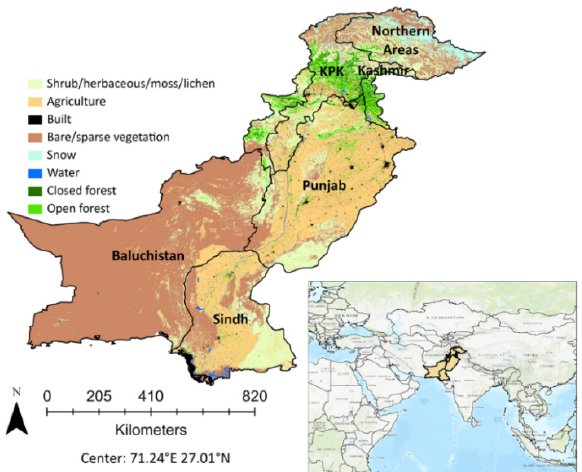
Figure 1. Forest cover in Pakistan (Buchhorn, M.; Smets, B.; Bertels, L.; De Roo, B.; Lesiv, M.; Tsendbazar, N.-E.; Herold, M.; Fritz, S. Copernicus Global Land Service: Land Cover 100 m: collection 3: epoch 2019: Globe 2020).